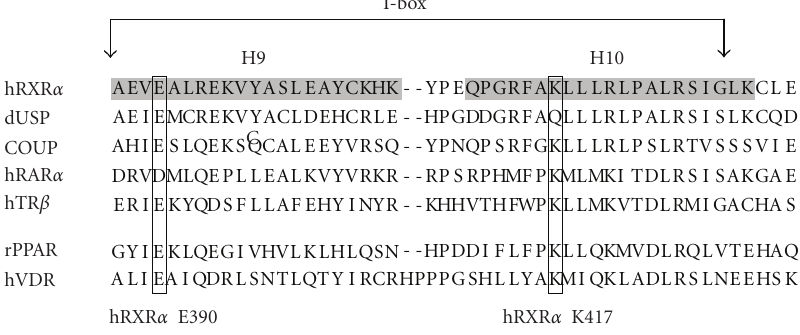
Figure 3: Amino acid sequences of the I-box region of RXR α , USP, COUP, RAR α , TR β , PPAR, and VDR. The I-box lies within Helix 9 (H9) and helix 10 (H10) (shaded) and has been shown to be essential to dimerization. The amino acid residues equivalent to hRXR α E390 and K417 are also marked.